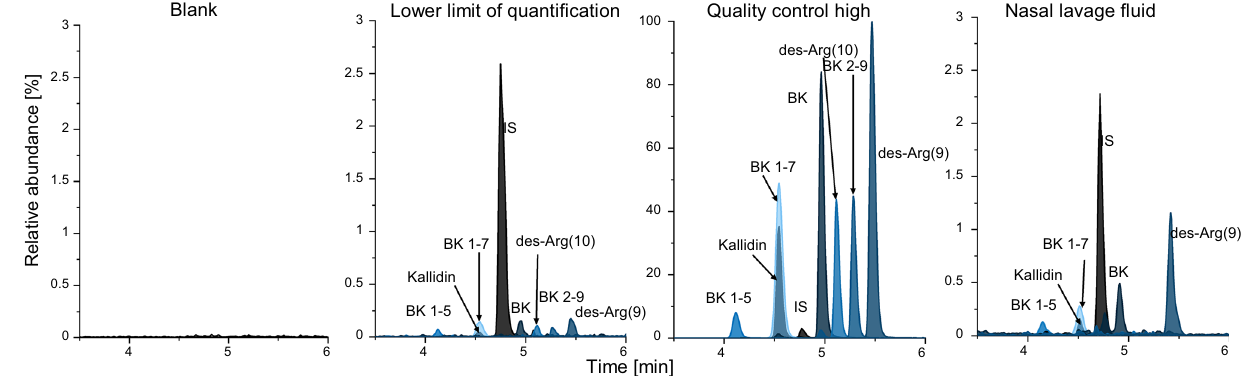
Figure 4. Representative chromatograms for the kinin peptides. The nasal lavage fluid was obtained in a healthy volunteer. BK: bradykinin, des-Arg(9): des-Arg(9)-bradykinin, des-Arg(10): des-Arg(10)-kallidin, IS: internal standard.